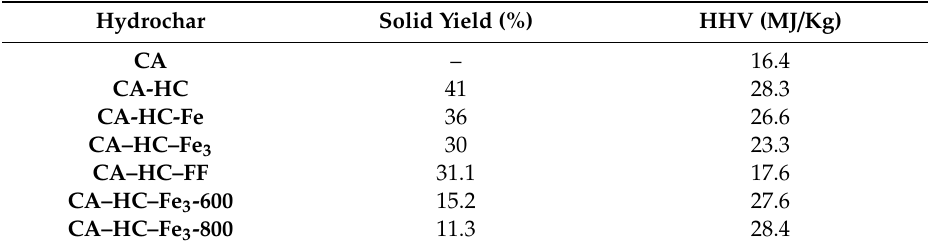
Table 1. Values of solid yield (%) and high heating value (MJ Kg − 1 ) of hydrochars (HCs). Hydrochar